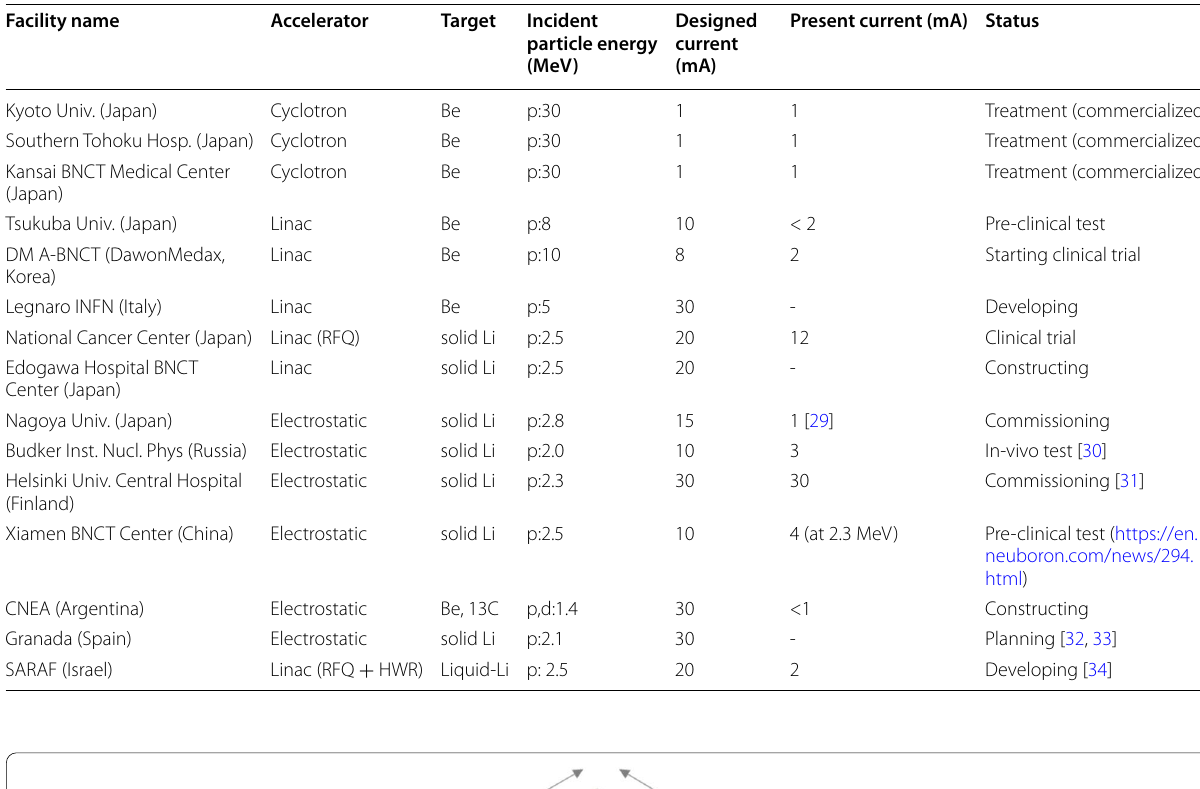
Table 2 List of A‑BNCT facilities around the world